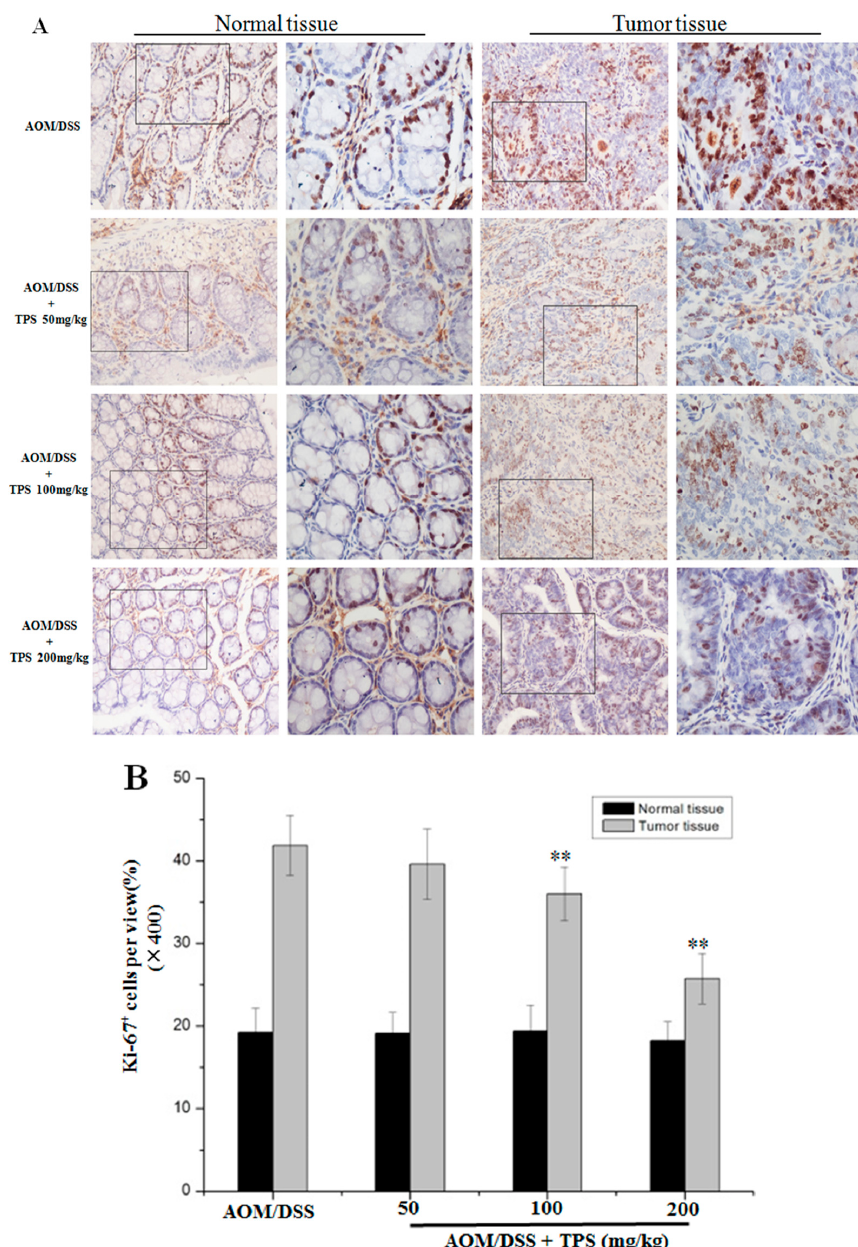
Figure 3. Paraffin-embedded colon sections were stained with Ki-67 for assessment of proliferation. ( A ) TPS significantly altered expression of Ki-67. Representative images from immunostaining of tumor tissue samples ( n = 6) with antibodies against Ki-67 (original magnification 200× and 400×). ( B ) Quantification of Ki-67-positive cells per view (400×, n = 10) showed that the number of Ki-67 + cells was significantly decreased in colonic tumor tissues of TPS-treated mice compared with AOM/DSS mice. Bar graphs show mean ± SD of three independent experiments. ** p < 0.01, vs. AOM/DSS group.